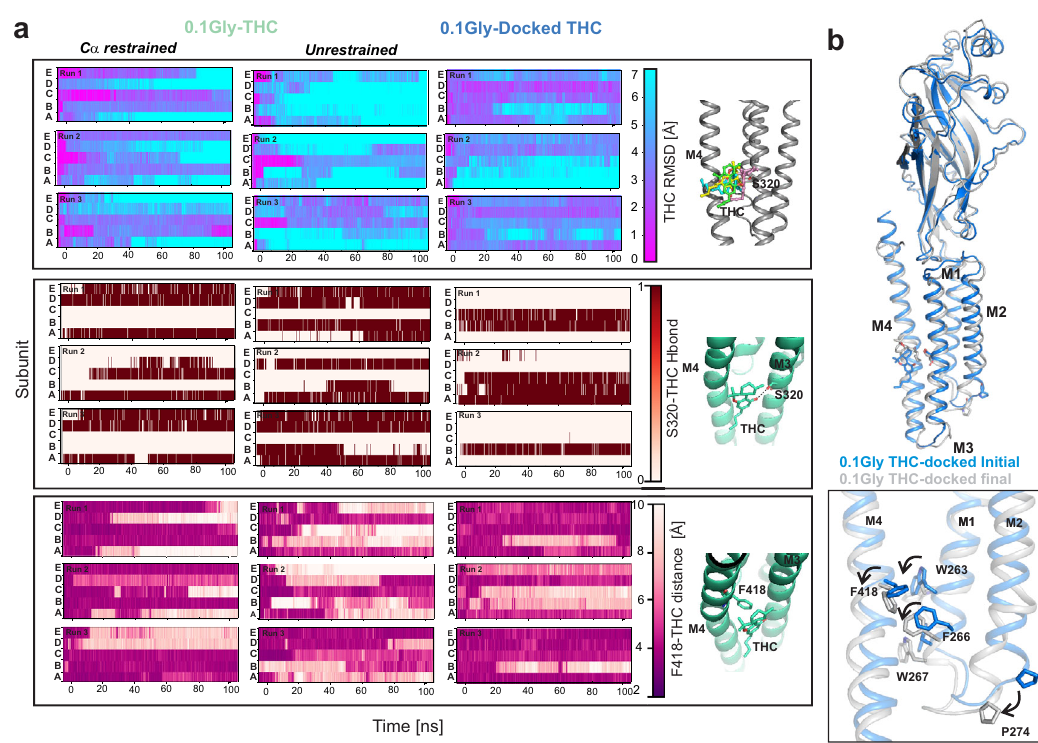
Fig. 5 | Assessment of THC binding pose.a The stability of the THC binding pose was assessed in the GlyR-0.1gly-THC structure during simulations with either C α - restraintsorunderunrestrainedconditions.TheTHCmoleculewasalsodockedon to the GlyR-0.1gly structure in the same binding pose as observed in the GlyR- 0.1gly-THC structure. The time evolution of the RMSD of the heavy atoms of each THC molecule with respect to the starting conformation was computed for the threerepeatsforeachsimulatedsystem( toppanel) .Priortothecalculationofeach THC RMSD, a least-squares fi tting was performed on the C α atoms of the protein subunitwheretherespectiveTHCwasbound.Insetontherightshowsthedifferent